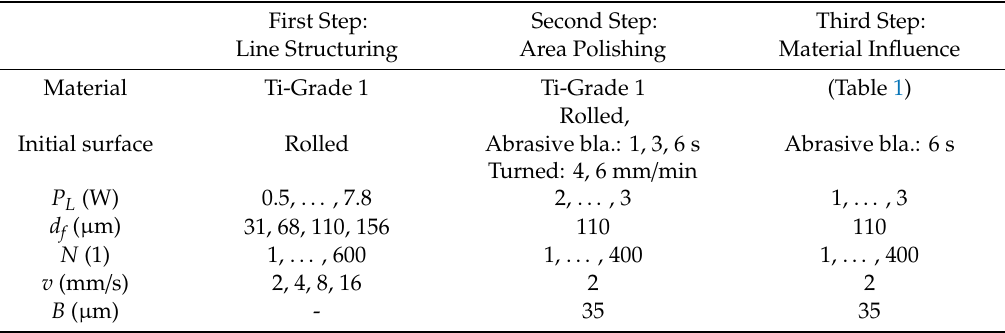
Table 2. Overview of the conducted experiments and their machining